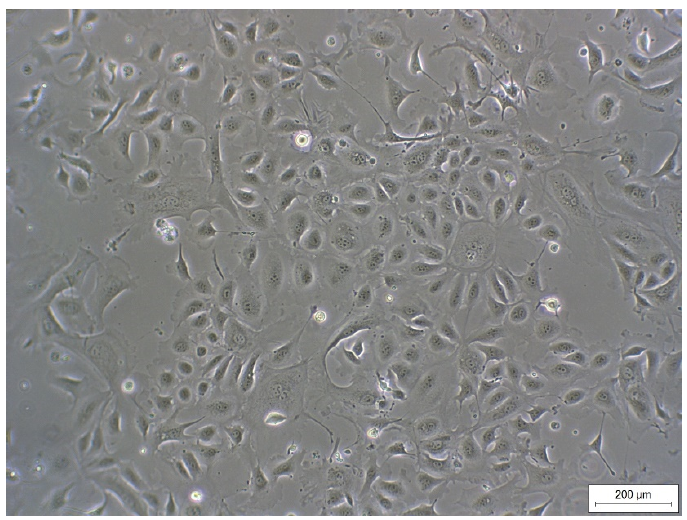
Figure 1. Monolayer of REC (passage 3) isolated from rumen epithelial tissue of dairy cows showing a typical epithelial cobblestone morphology.